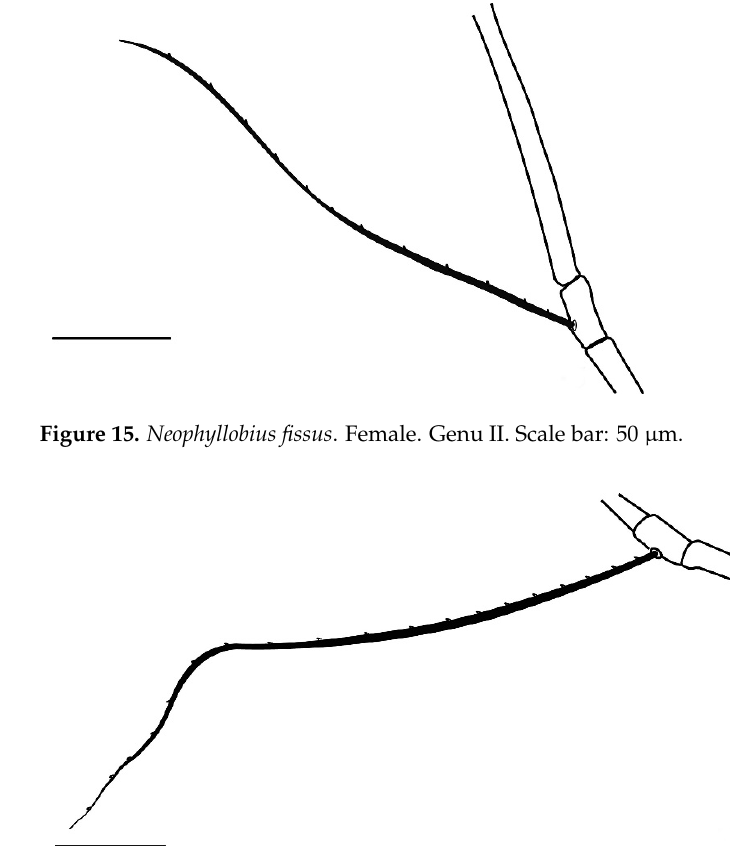
Figure 16. Neophyllobius fissus . Female. Genu III. Scale bar: 50 μ m.